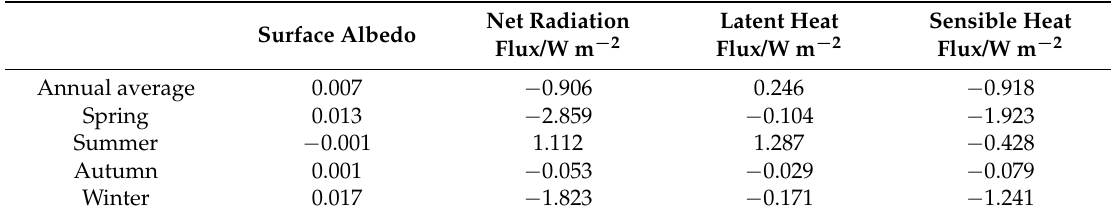
Table 3. Mean changes in surface solar radiation and the heat flux budgets of grid cells containing forests converted into cropland (i.e., sensitive simulations minus the